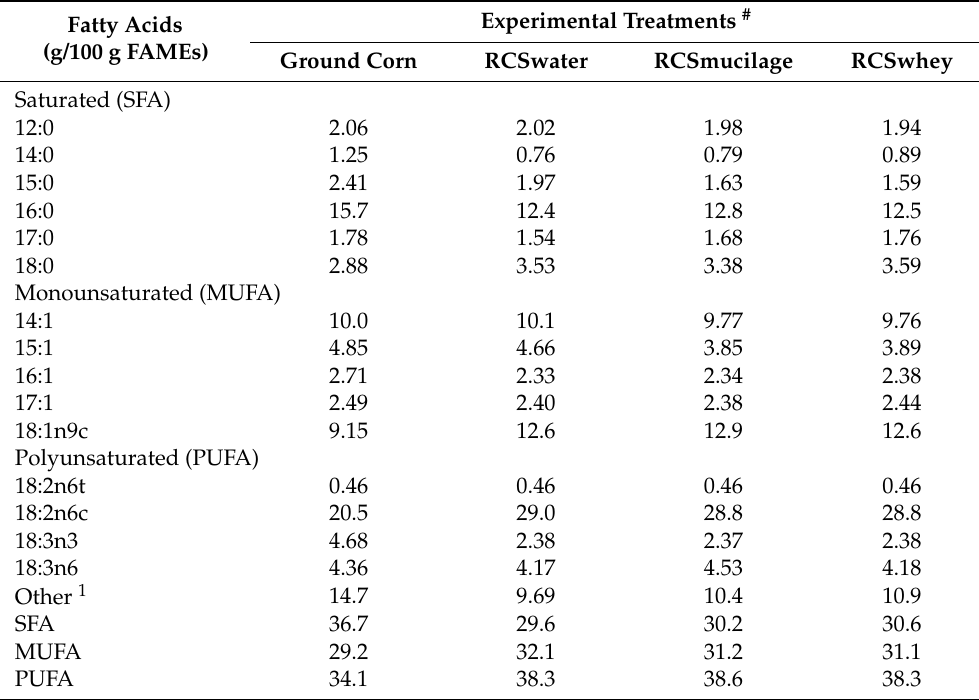
Table 2. Fatty acid profile of rehydrated corn-grain silages used in the goat kids feeding. Experimental Treatments # Fatty Acids (g/100 g FAMEs) Ground Corn